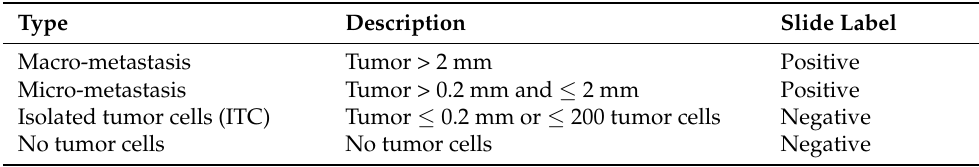
Table 2. Slide-label classification based on the WHO TNM classification system